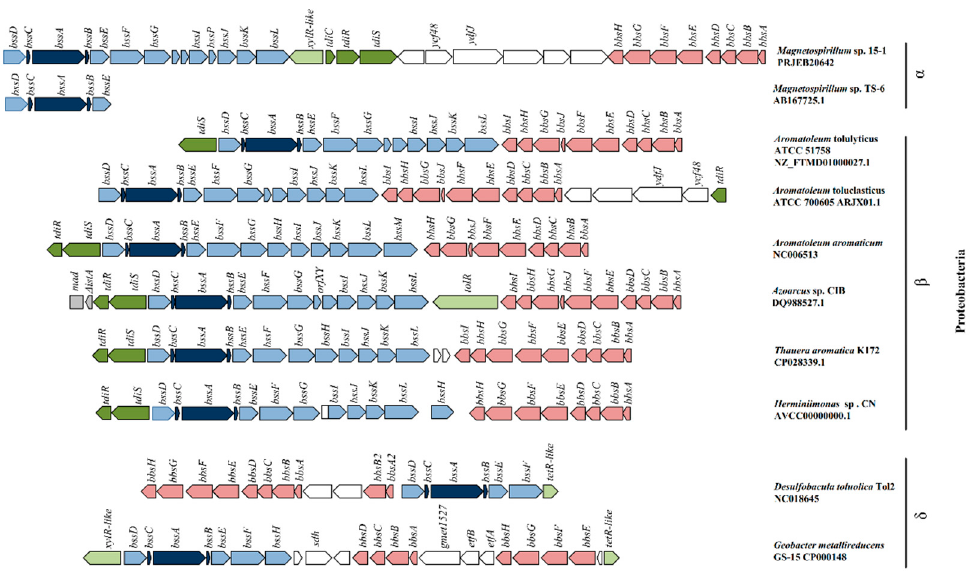
Figure 1. Organization and comparison of the bss–bbs gene region in selected bacteria capable of anaerobic toluene degradation. Genes are represented by arrows: ‘dark blue’ for bssABC ; ‘light blue’ for accessory bss genes; ‘pink’ for genes needed for transformation of benzylsuccinate to benzoyl-CoA; ‘olive’ for tdi genes; ‘light green’ for putative regulator-coding genes; ‘white’ for remaining genes without evidence for involvement in anaerobic toluene degradation. The gene names are as follows: bssABC and bssD subunits code for a benzylsuccinate synthase and its corresponding activase, respectively; bssE , putative chaperone; bssG-J and bssL , unknown function; bssK , mRNA binding protein; xylR , σ 54 -dependent regulator, tdiC , regulator of TdiR activity; tdiR , toluene degradationregulator; tdiS ,toluenedegradationinducingsensor; bbsEF ,(3-methyl)benzylsuccinateCoA transferase; bbsG , (3-methyl) benzylsuccinyl-CoA dehydrogenase; bbsH , (3-methyl) phenylitaconyl-CoA hydratase; bbsCD , 2-[hydroxyphenyl(methyl)]-succinyl-CoA dehydrogenase; bbsAB , BbsAB, (3-methyl) benzoylsuccinyl-CoA